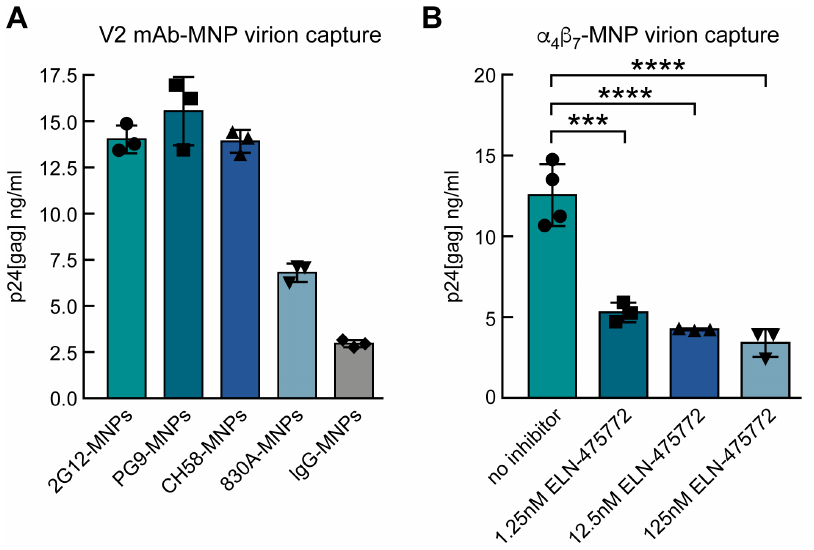
Fig 5. Virion capture by V2 mAbs and α 4 β 7 coated nanoparticles. A) Capture of 92TH023 by MNPs coated with gp120 mAbs including 2G12 (positive control) and V2 mAbs PG9, CH58 and 830A. A non-specific Ig was employed as a negative control. Virion capture was determined by detection of MNP-bound p24 (Y-axis). Results from three independent experiments are shown. B) 92TH023 virion capture by α 4 β 7 -MNPs in the absence or presence of increasing concentrations of ELN-475772. Results from three independent experiments are shown. Detection of MNP -captured virus as in panel A. Error bars indicate SEM. Significance measure by ANOVA followed by the Tukey multiple comparison test ( (cid:3)(cid:3)(cid:3) p < 0.001 and (cid:3)(cid:3)(cid:3)(cid:3) p < 0.0001).